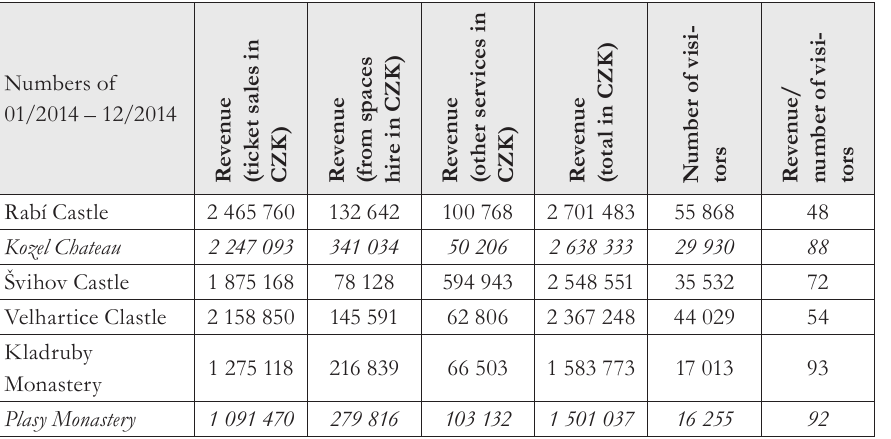
Tab. 2 - Statistic figures of top Pilsen region monumens. Source: Statistics of the National Heritage Institute